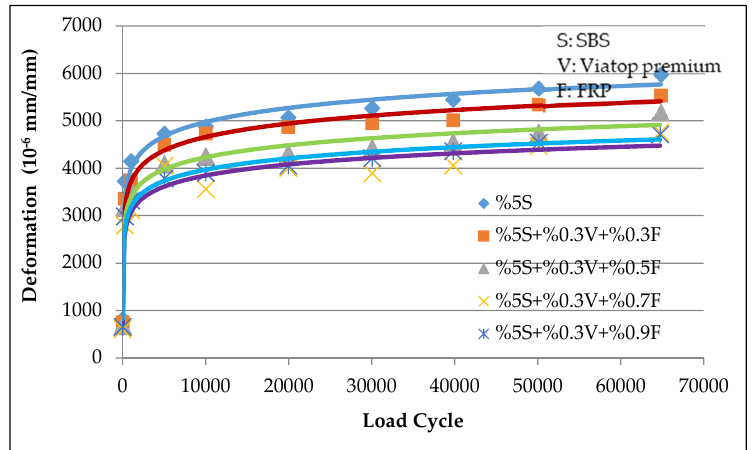
Figure 12. Deformation-Load Repetition. Fibers 2020 , 8 , x FOR PEER REVIEW